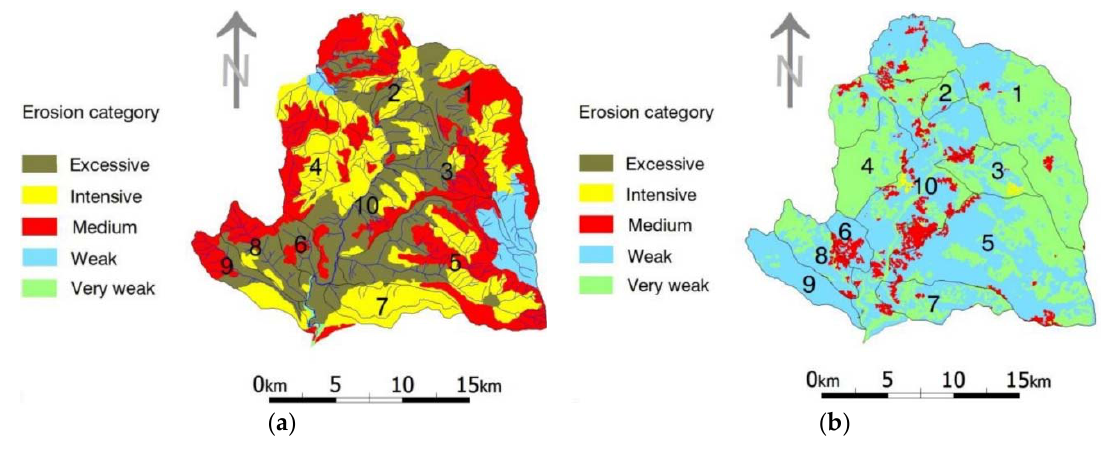
Figure 5. Soil erosion maps: ( a ) in 1953 [38]; ( b ) in 2016 year.